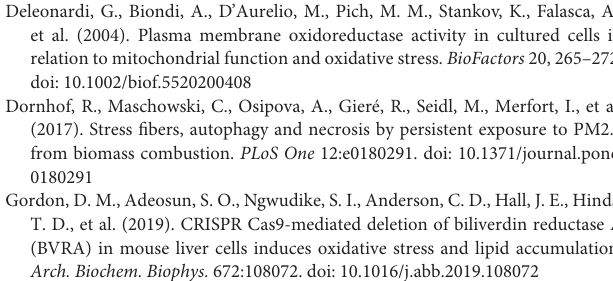
Supplementary Figure 1 | Activation of lysosomal function in cells in the absence and presence of PM 2 . 5 . (A) L02 and TRPV6 overexpression cells were treated with PM 2 . 5 . Cells were then stained with LysoSensor TM Green DND-189. There was no difference between groups; (B) cathepsin B and cathepsin D activities in lysosome were determined by Cathepsin B Activity Assay Kit. TRPV6 and PM 2 . 5 do not affect the activation of lysosomal function in cells. Supplementary Table 1 | Top-rank genes with a high number (4–6) of unique sgRNAs involved in PM 2 . 5 toxic effect. Average: Sum divided by count; Count: The unique sgRNAs number of the gene; HGLibA/Bxxx; Code assigned to each sgRNA in the GeCKO Library; sgRNA: Short-guided RNA; sum: Total number of sgRNA readings per gene. Data are representative of three independent experiments with n = 3 (Mean ± SEM), normalized by NC group. Supplementary Table 2 | KEGG pathway analysis of higher PM 2 . 5 resistance genes. Pathway: The name of the KEGG pathway, Overlap: The ratio of the number of overlapping genes to the number of genes entered, P-value: Use Fisher’s exact test to calculate the P-value, Odds Ratio: The deviation from the expected ranking, Composite score: Multiplying the logarithm of the p-value from the Fish exact test by the deviation z- score from the expected ranking, Gene: Overlapping genes between inputs and paths. Supplementary Table 3 | GO enrichment analysis of the top-rank PM 2 . 5 resistance top-rank genes. (Function: GO analysis function name, Overlap: Ratio of overlapping genes to input genes, P values, Odds Ratio, comprehensive scores, and genes: same with legends of Supplementary Table 2